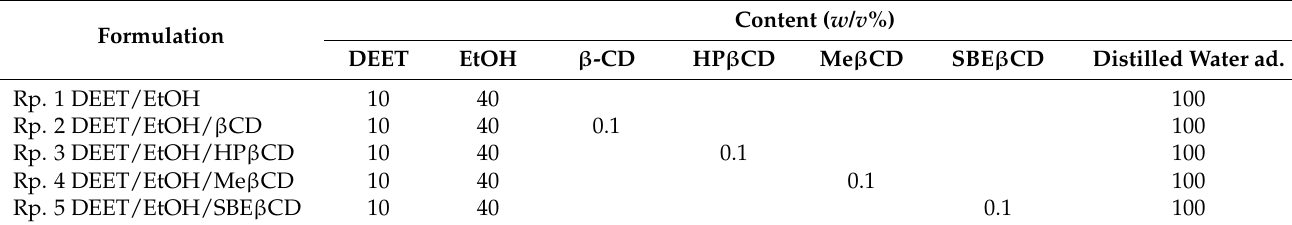
Table 1. Formulations of DEET/EtOH/CD in this study. Formulation